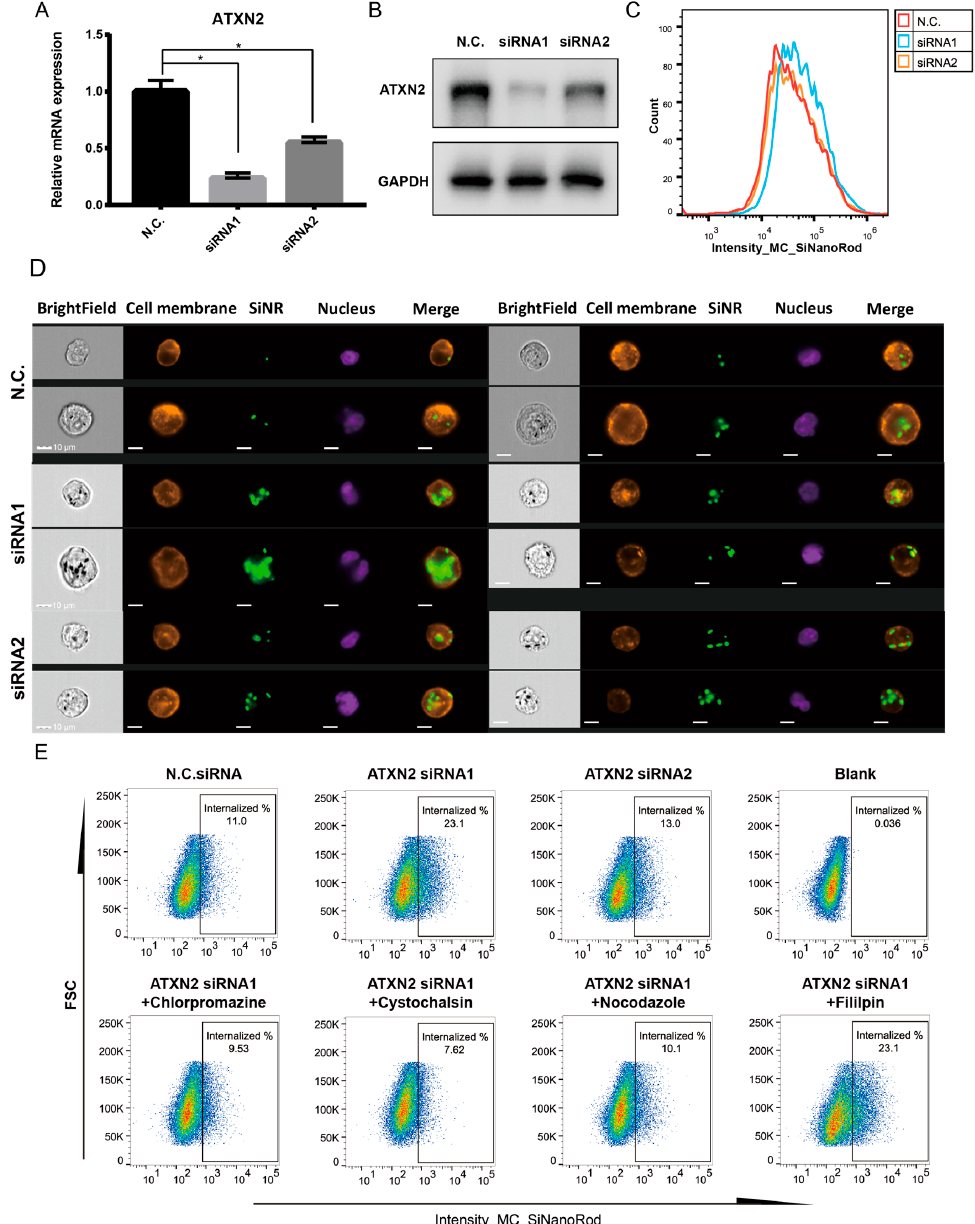
Figure 8. Verification of the role of ATXN2 in SiNR internalization. ( A ) Real ‐ time PCR for ATXN2 knockdown validation in Panc ‐ 1 cell lines. A multiple t ‐ test was performed with three biological replicates per group, * p < 0.05. ( B ) Western blot for ATXN2 knockdown validation in Panc ‐ 1 cells. GAPDH was used as loading control. ( C ) Intensity histogram of SiNR in Panc ‐ 1 cell. Red line is the negative control; orange line is the siRNA1 ‐ transfected cells; blue line is the siRNA transfected cells. ( D ) Four selected imaging cytometry images per population. The panels of one group of images are as follows: bright field, cell membrane, SiNR, nucleus, and merge of cell membrane and SiNR. Scale bar represents 10 μ m. ( E ) Spot plot of FSC (forward light scatter) vs. SiNR FAM fluorescence. Panc ‐ 1 cells with indicated treatment were incubated with Panc ‐ PDX@SiNR. All cells subjected to analysis were first plotted by FSC vs. SSC (side light scatter), followed by gating for single cell population and then nucleus ‐ stained cells (Hoechst). ”Internalized” gate was set for gating SiNR positive cells based on a blank control (no SiNR). The working concentrations of the chemical inhibitors were chlorpomazine 30 μ M, cystochalsin D 500 nM, nocodazole 20 μ M, and filipin 40 μ g/mL.